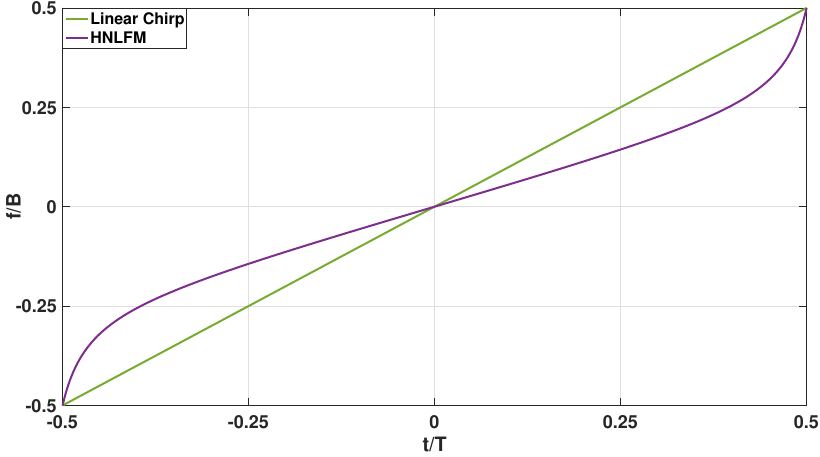
Figure 15. Normalized instantaneous frequency for linear chirp and hybrid non linear frequency modulation